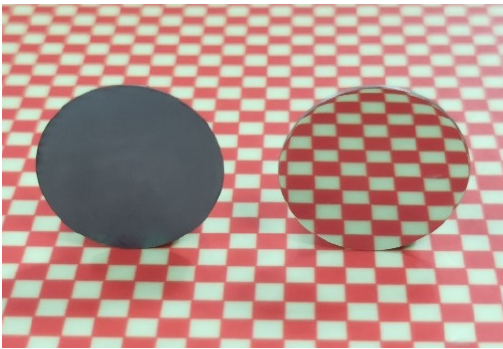
Figure 11. The tungsten samples before and after polishing.